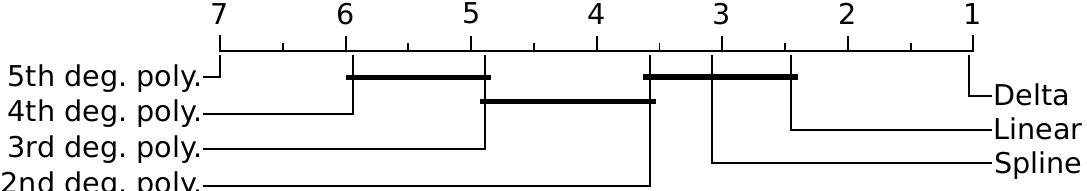
Figure 6. Mean performance ranking of proposed methods compared using the Nemenyi test. Groups of methods that are not significantly different (at p = 0.05) are connected. Delta encoding being close to one is due to outperforming all other techniques in nearly every test case. Spline on the other hand was ranked third on average, but ranked higher or lower for some test